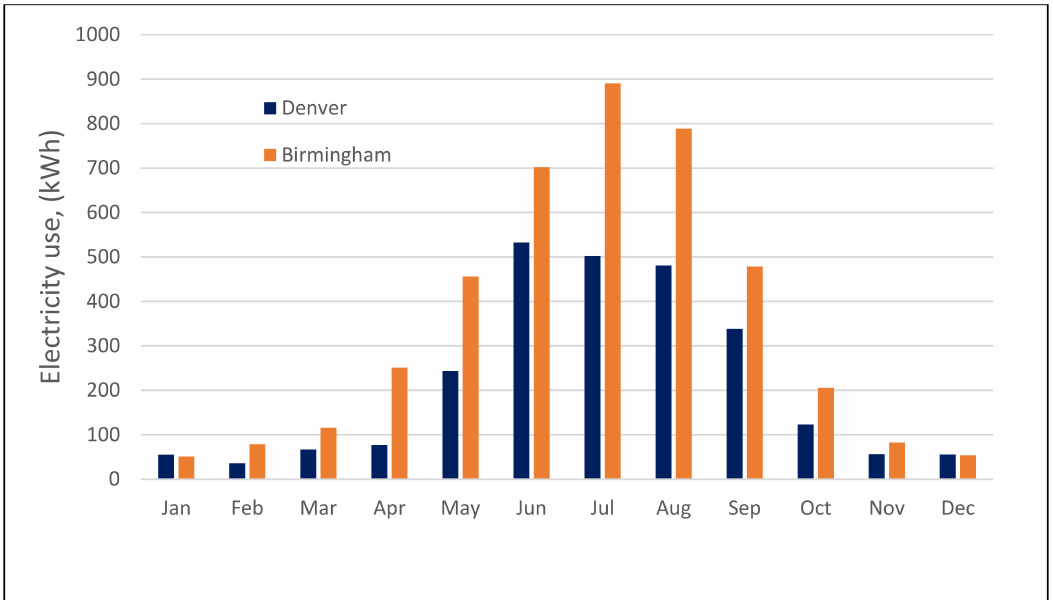
Figure 4. Annual electricity consumption for cooling for the two